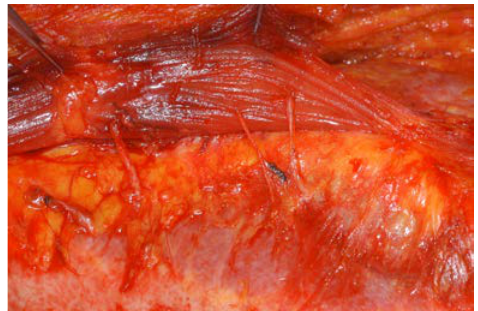
Figure 3. Preserved rectus muscle with innervated intercostal nerve (red arrows). The yellow arrow indicates the rectus muscle that is used as the pedicle, and the muscle held by the Army-Navy re- tractor is the preserved rectus muscle.